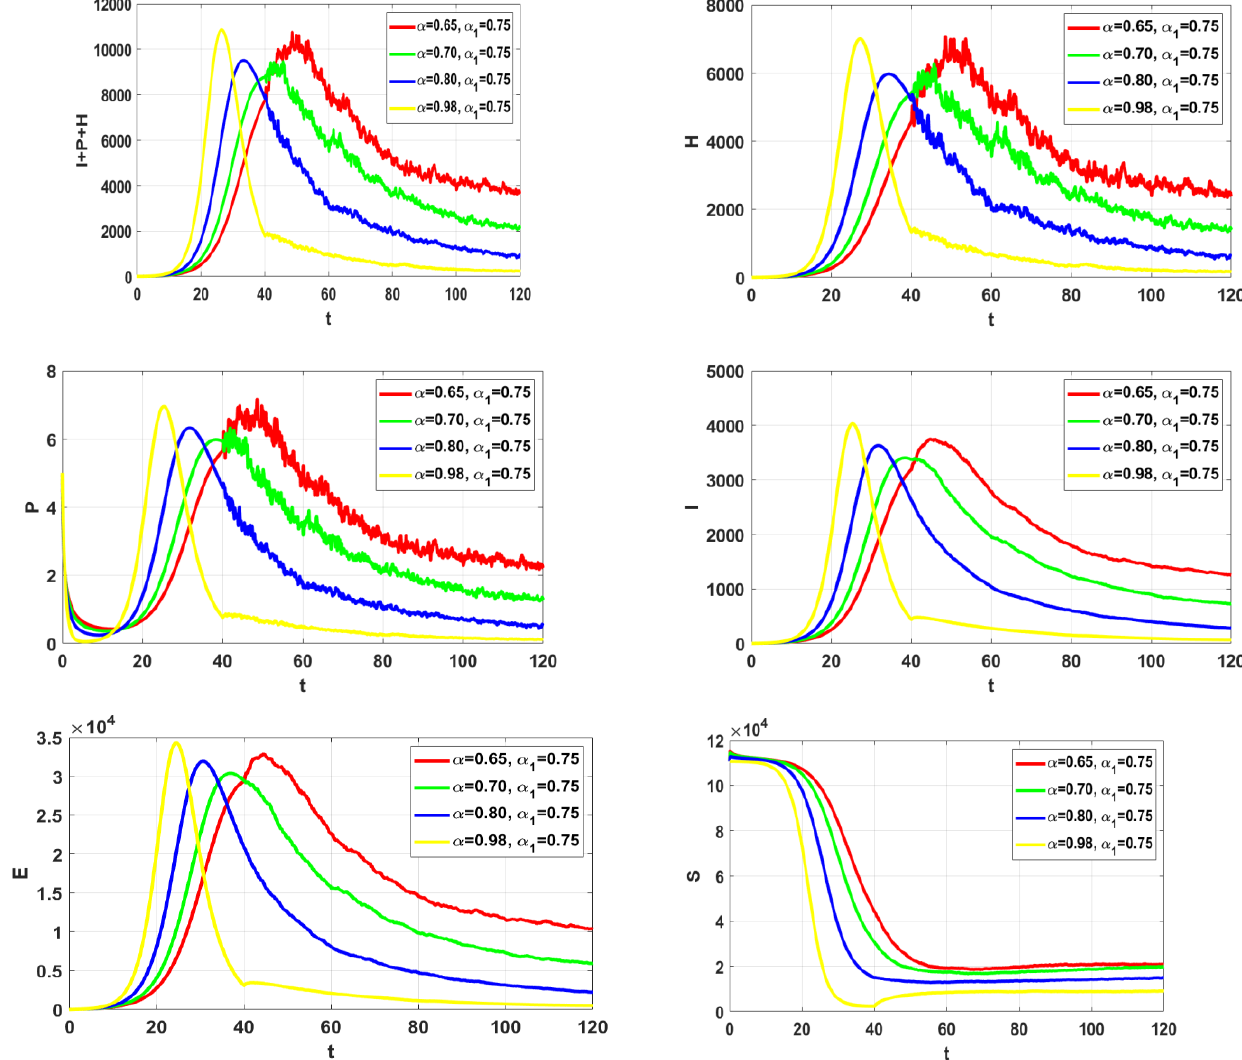
Figure 7 . Numerical simulation for system (14-16) at 𝐻 ∗ = 0.95, 𝛼 1 = 0.75 and different , Figure 7. Numerical simulation for system (14–16) at H ∗ = 0.95, α 1 = 0.75 and different α , σ 1 = σ 2 = 𝜎 = 𝜎 = 𝜎 = 0.01 , 𝜎 = 𝜎 = 𝜎 = 𝜎 = 𝜎 = 0.1 . 1 2 3 4 5 6 7 8 σ 3 = 0.01, σ 4 = σ 5 = σ 6 = σ 7 = σ 8 =